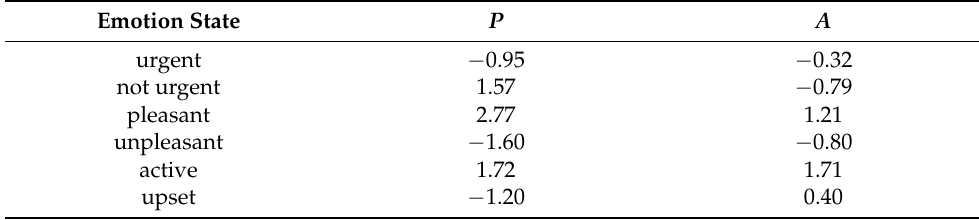
Table 1. Initial emotion